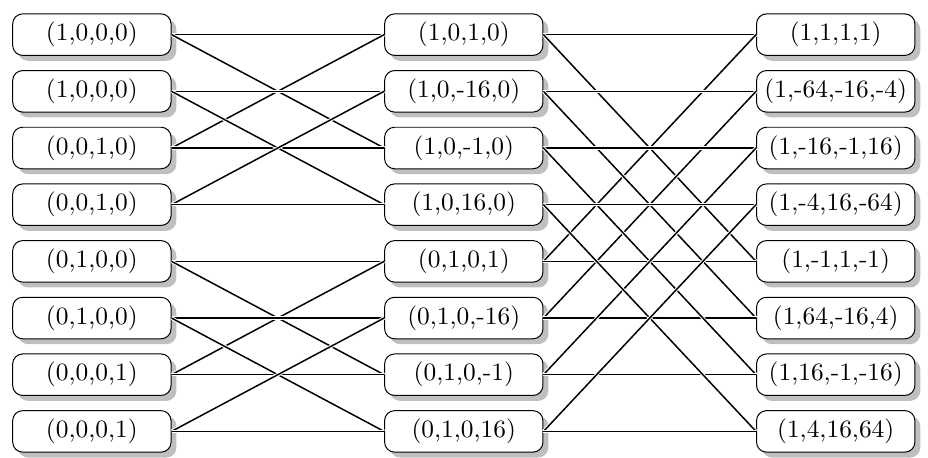
Figure 5: Circuit of the degree-8 NTT applied on an order-4 encoding x = ( x 0 , x 1 , x 2 , x 3 ) for the prime field F . Probing a node i reveals h u 257 Each butterfly (a subcircuit of the form ./ ) computes ( c , d ) ← ( a + λ b , a − λ b ) given an input ( a , b ) and a fixed λ